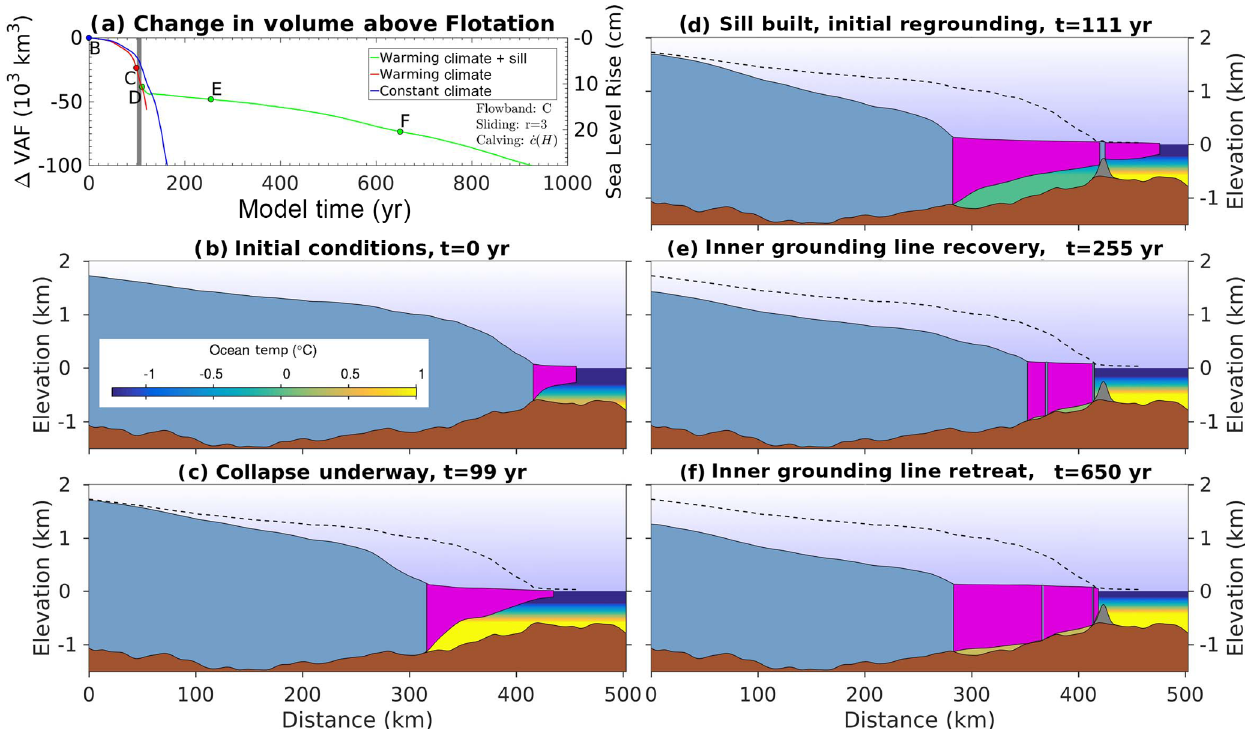
Figure 5. Example model output for an intervention that regrounded Thwaites glacier and slowed (but not reversed) sea level rise. The sill blocked 50% of the warm water in this scenario. (a) Time series of volume above flotation and equivalent sea level rise. Vertical gray bars show when the sill was built. Snapshots (b–f) show model geometry and ocean temperature. Brown regions represent bedrock, pale blue represents grounded ice, purple represents the floating ice shelf, and gray represents the sill. Dashed lines represent the initial ice surface. Vertical exaggeration is 50. This model run is also shown in Animation 3 in the